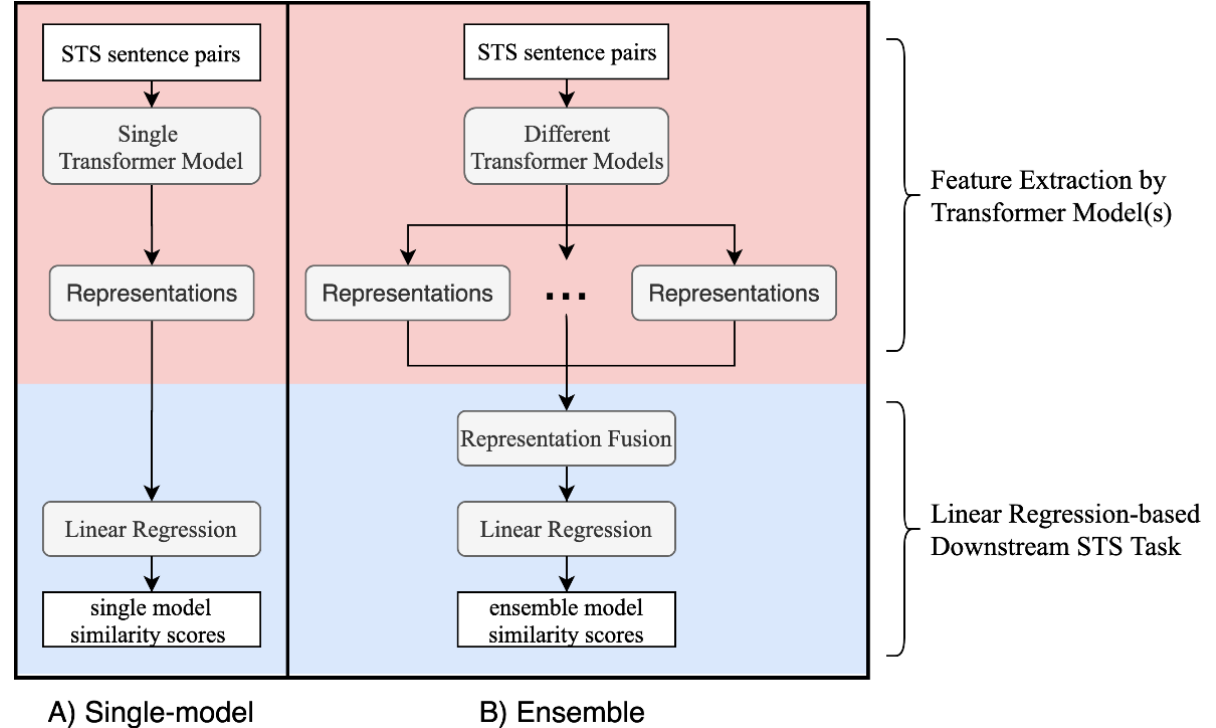
Figure 1. An overview of our single-model and ensemble solutions for clinical STS. STS: semantic textual